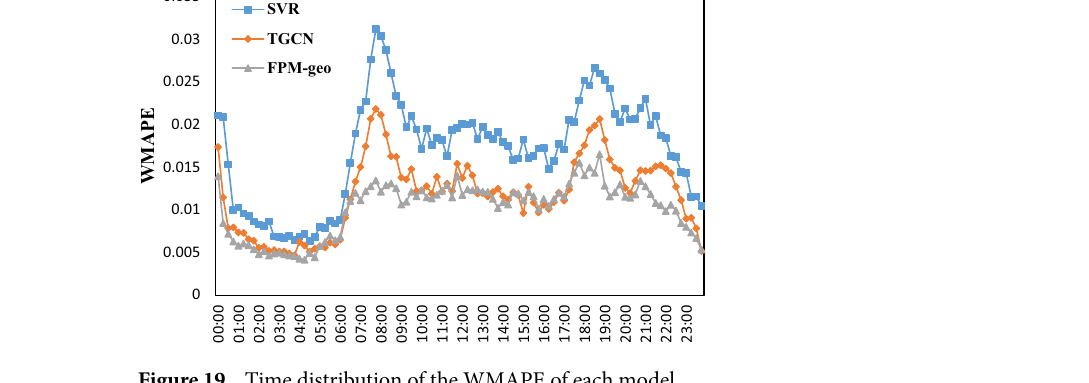
Figure 19. Time distribution of the WMAPE of each